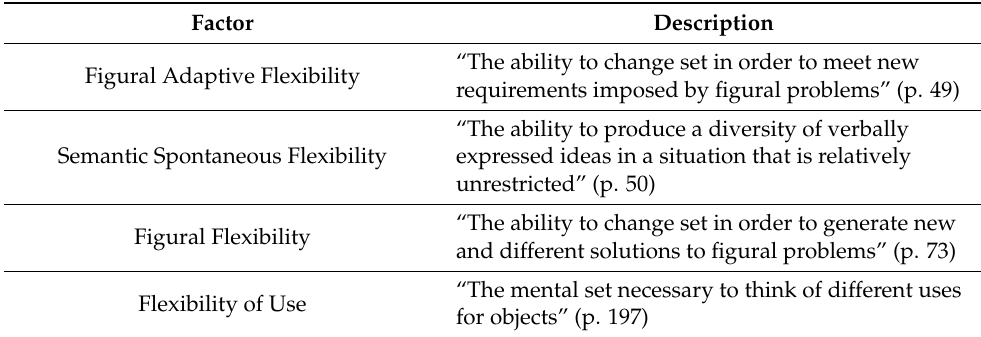
Table 1. Flexibility factors from the Kit of Reference Tests for Cognitive Factors (Ekstrom et al. 1976; French et al. 1963). Factor Description “The ability to change set in order to meet new Figural Adaptive Flexibility requirements imposed by figural problems” (p. 49) “The ability to produce a diversity of verbally Semantic Spontaneous Flexibility expressed ideas in a situation that is relatively unrestricted” (p. 50) “The ability to change set in order to generate new Figural Flexibility and different solutions to figural problems” (p. 73) “The mental set necessary to think of different uses Flexibility of Use for objects” (p.